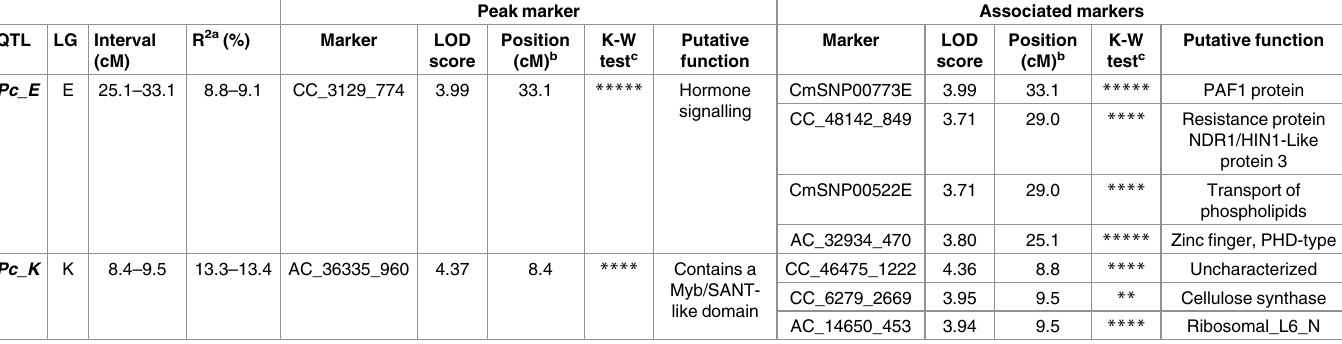
Table 2. Results of MQM mapping for QTLs conferring resistance to P . cinnamomi in a C . sativa x C . crenata population.